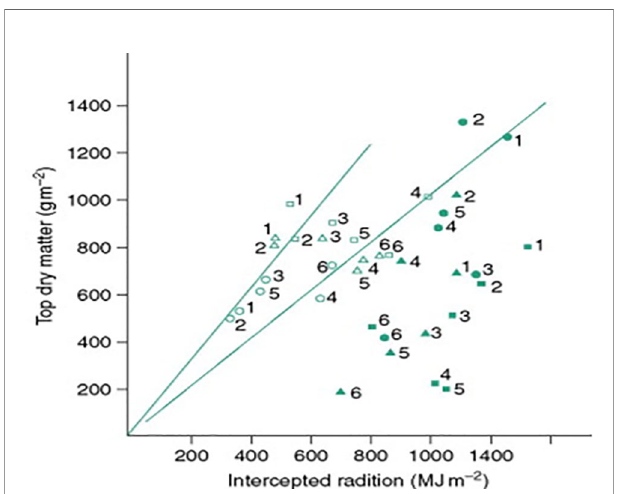
FIGURE 2 | Growing media provides anchorage. aeration, water and nutrients. (Adopted from: Dumroese et al., 2008).